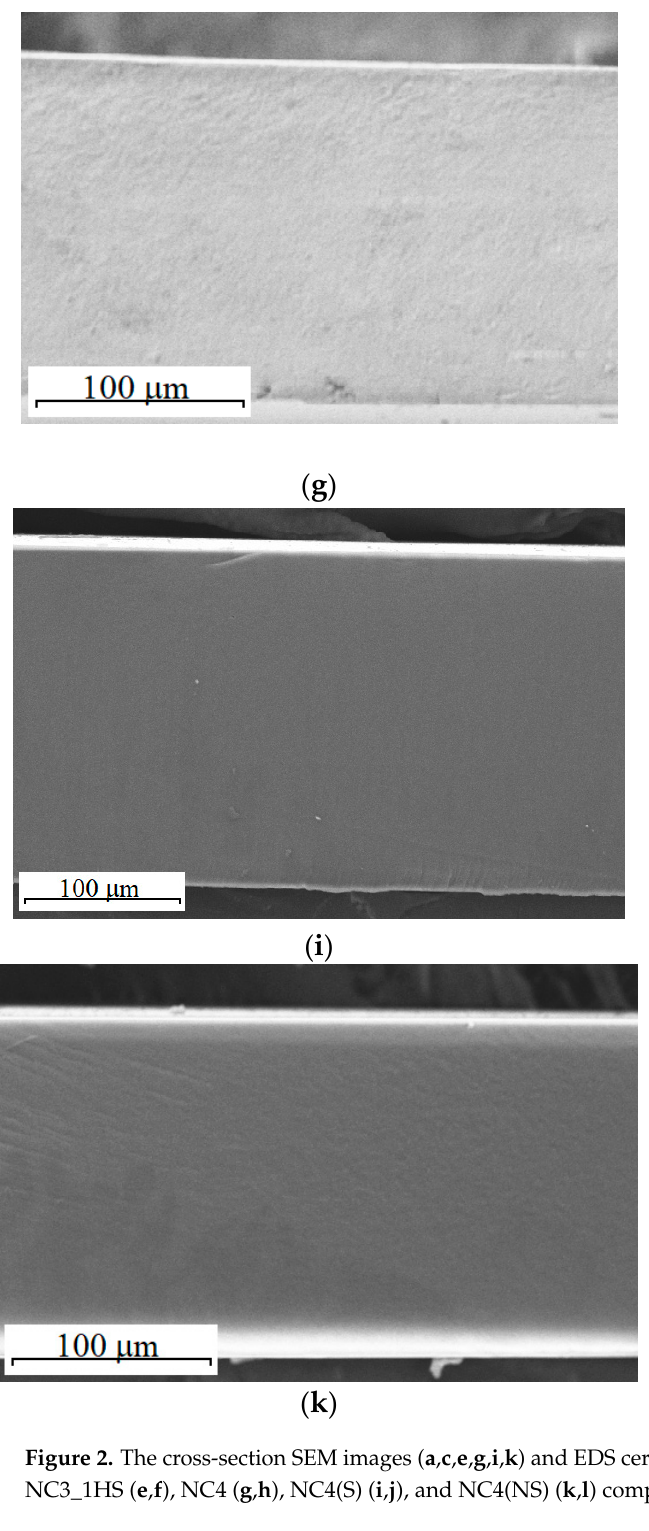
Figure 3. TEM image of the NC3 ‐ 0.2S hybrid membrane.